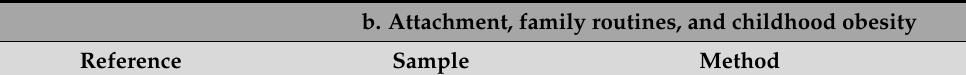
Table 2. Cont. b. Attachment, family routines, and childhood